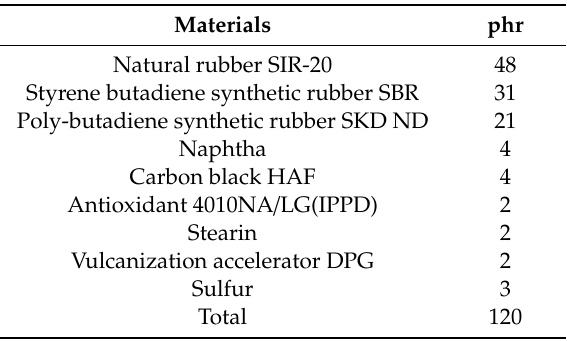
Table 2. The GDT rubber